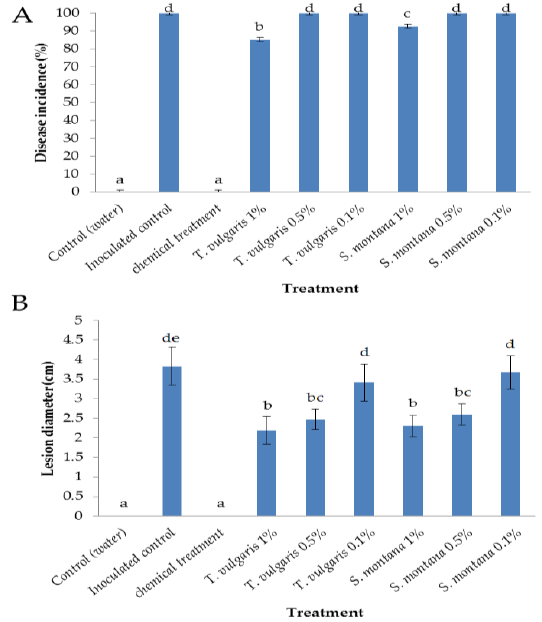
Figure 1. Antifungal activity of essential oils of Satureja montana and Thymus vulgaris applications at different concentrations (1%, 0.5%, and 0.1%) expressed as disease incidence ( A ) and lesion diameter ( B ) caused by B. cinerea on apples. Vertical lines represent the standard error for the average of three biological replicates. Applications followed by different letters are statistically different following Duncan’s multiple range test ( p < 0.05).